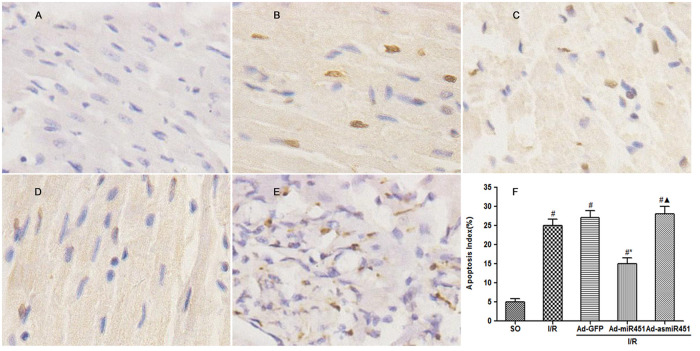
Effect of miR-451 on cardiomyocytes apoptosis.(A-E) Results of cardiomyocyte apoptosis in each group assessed by TUNEL staining. (F) The index of apoptosis was detected by counting TUNEL-positive myocytes randomly in 10 fields. #: vs P<0.05 compare with SO group; *: P<0.05 compare with I/R group; ▲: P>0.05 compare with I/R group.